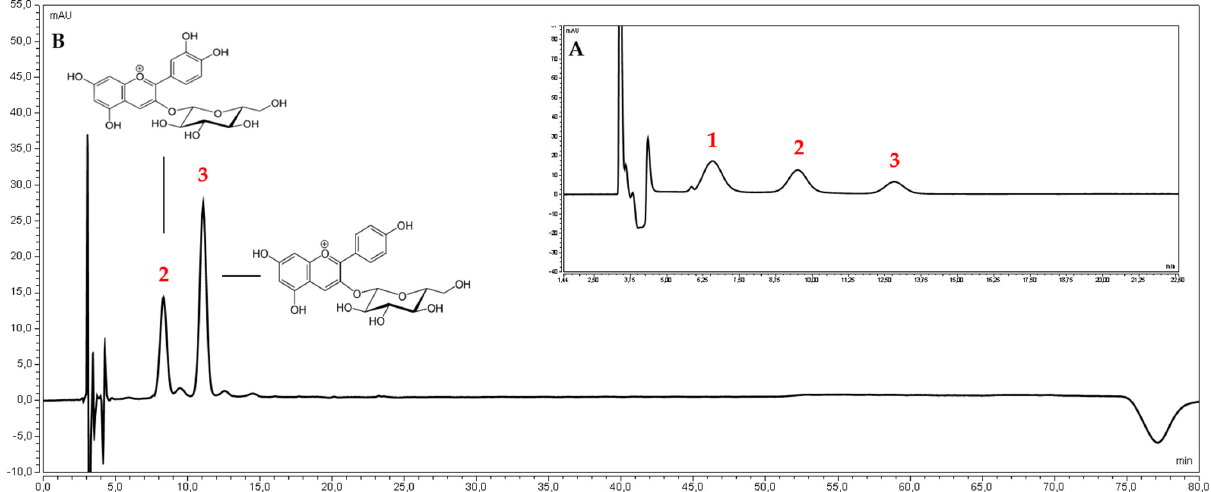
Figure 1. The chromatogram of the reference substances. ( A ) 1-delphinidin 3- O -glucoside, 2- cyani- din 3- O -glucoside, 3- pelargonidin 3- O -glucoside, and ( B ) water extract of Corni fructus cultivar Wydubieckij .